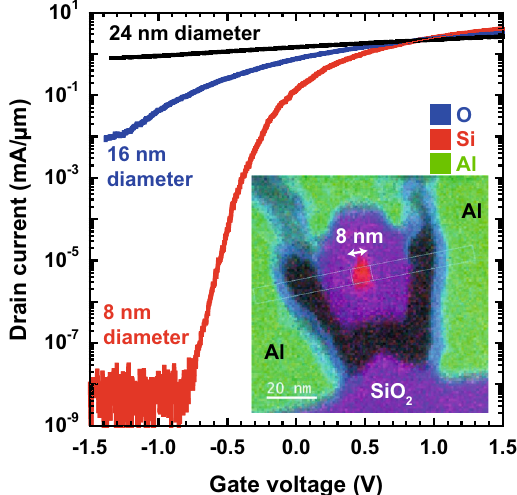
Figure 2. 3D to 1D dimensional transport change with nanowire diameter. The drain current, I D as a function of gate voltage for Si nanowires with three different diameters of 8 nm, 16 nm and 24 nm. The drain voltage, V D = 1.5 V and all measurements are at 293 K. The insert is an elemental map of a cross-section of the smallest nanowire, measured by TEM-EELS, which was used to determine the nanowire